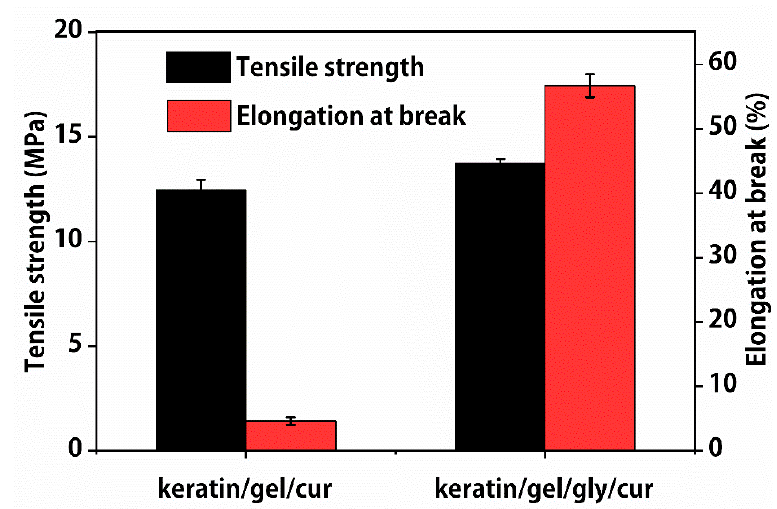
Figure 4. Tensile strength and elongation at break properties of keratin (7%)/gelatin (10%)/curcumin (1.0%) and keratin (7%)/gelatin (10%)/glycerin (2.0%)/curcumin (1.0%) composite films.